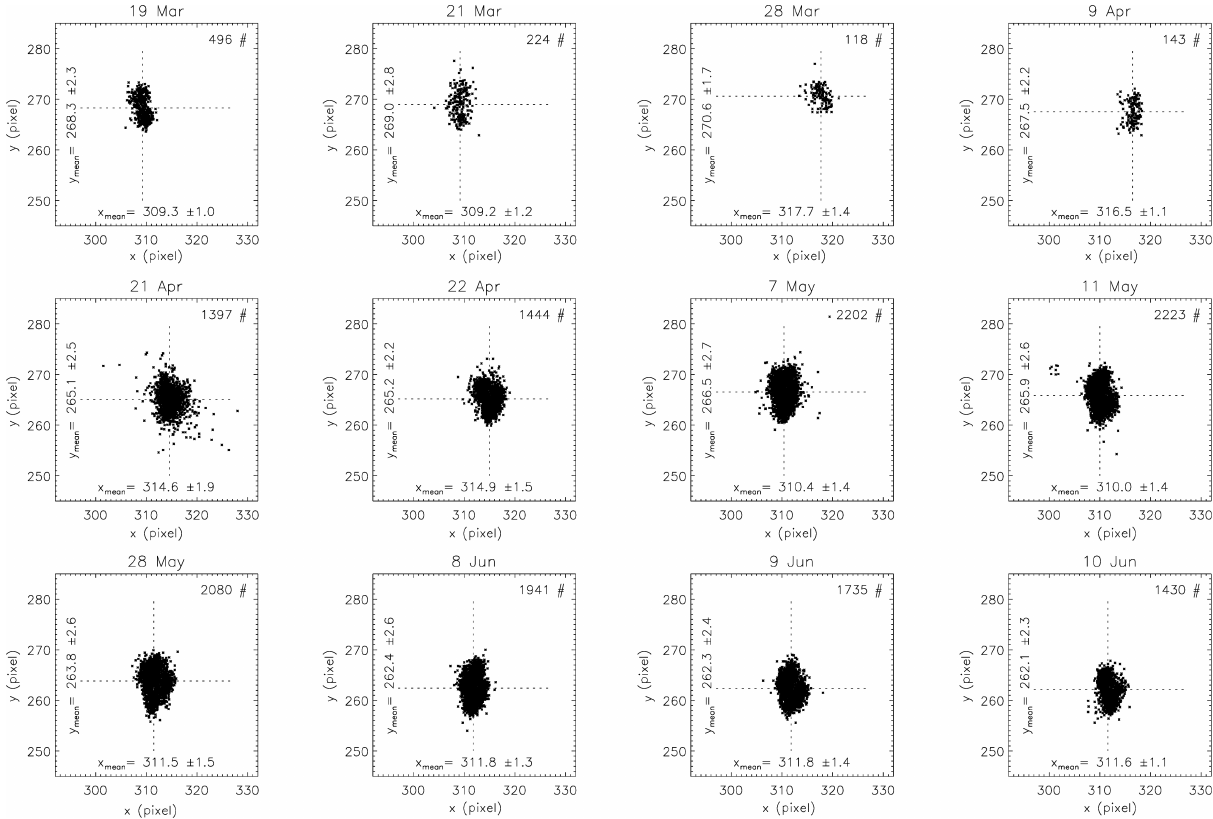
Figure 4. Solar disk center positions (black dots) determined by KSO-STREAMS, used for the determination of the mean daily zero-point centers on 12 clear-sky days in 2015. The zero-point center of KSO-STREAMS is defined as the mean value of these 12 zero-point